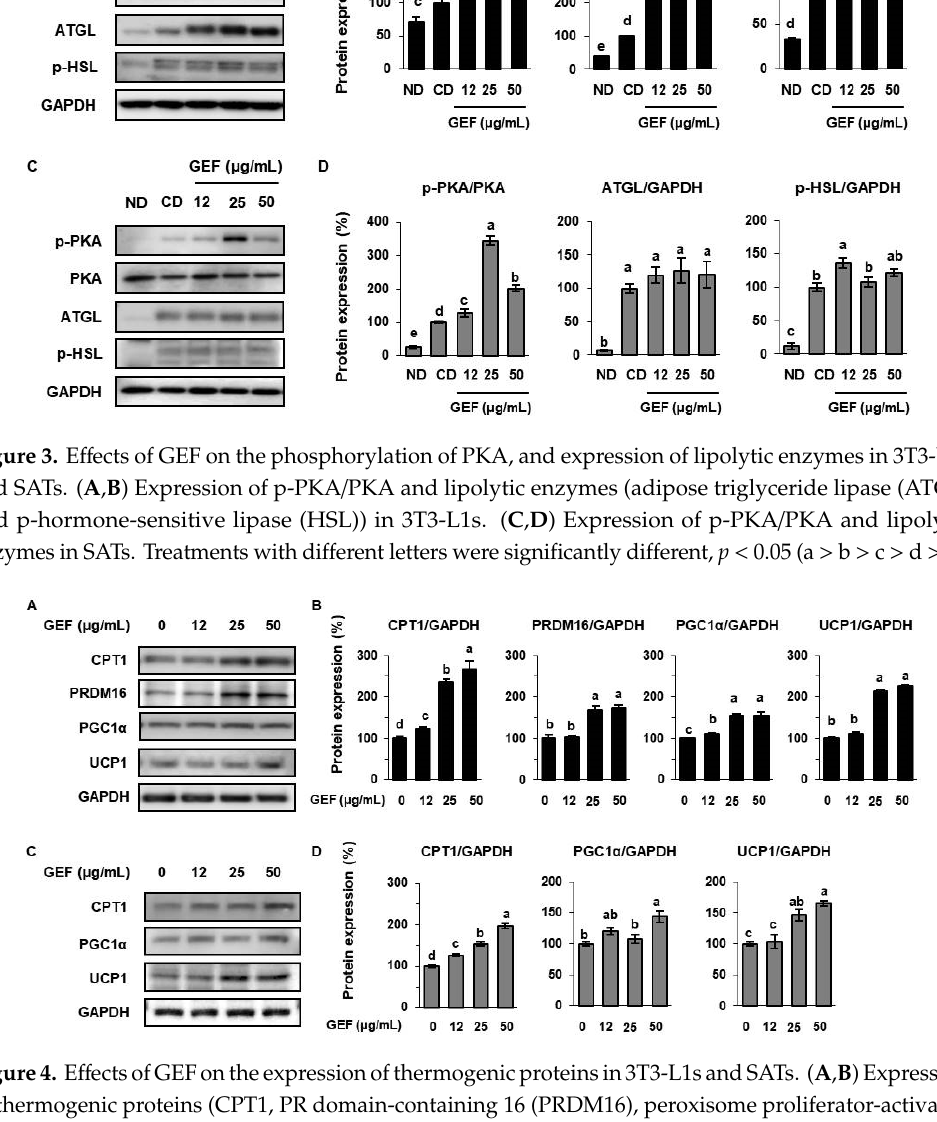
Figure 3. Effects of GEF on the phosphorylation of PKA, and expression of lipolytic enzymes in 3T3- L1s and SATs. ( A–B ) Expression of p-PKA/PKA and lipolytic enzymes (adipose triglyceride lipase (ATGL) and p-hormone-sensitive lipase (HSL)) in 3T3-L1s. ( C–D ) Expression of p-PKA/PKA and lipolytic enzymes in SATs. Treatments with different letters were significantly different, p < 0.05 (a > b > c > d > e).